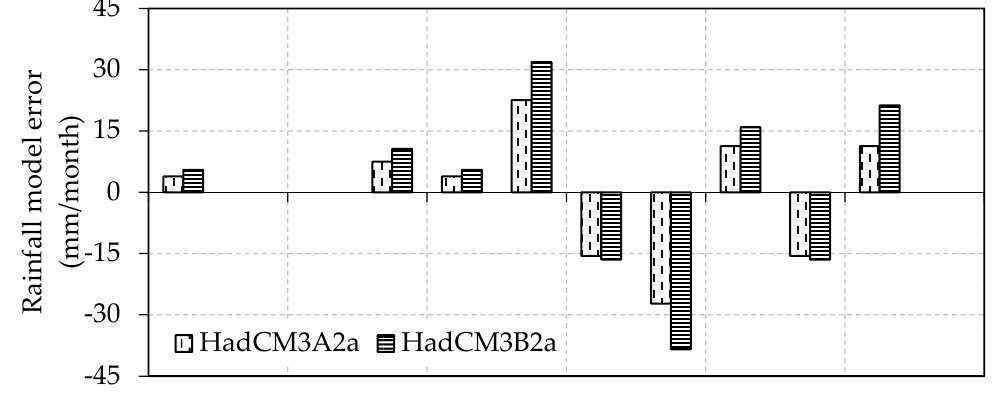
Figure 6. Downscaled precipitation of HadCM3A2a and HadCM3B2a model error from the baseline period (1961 to 1990).